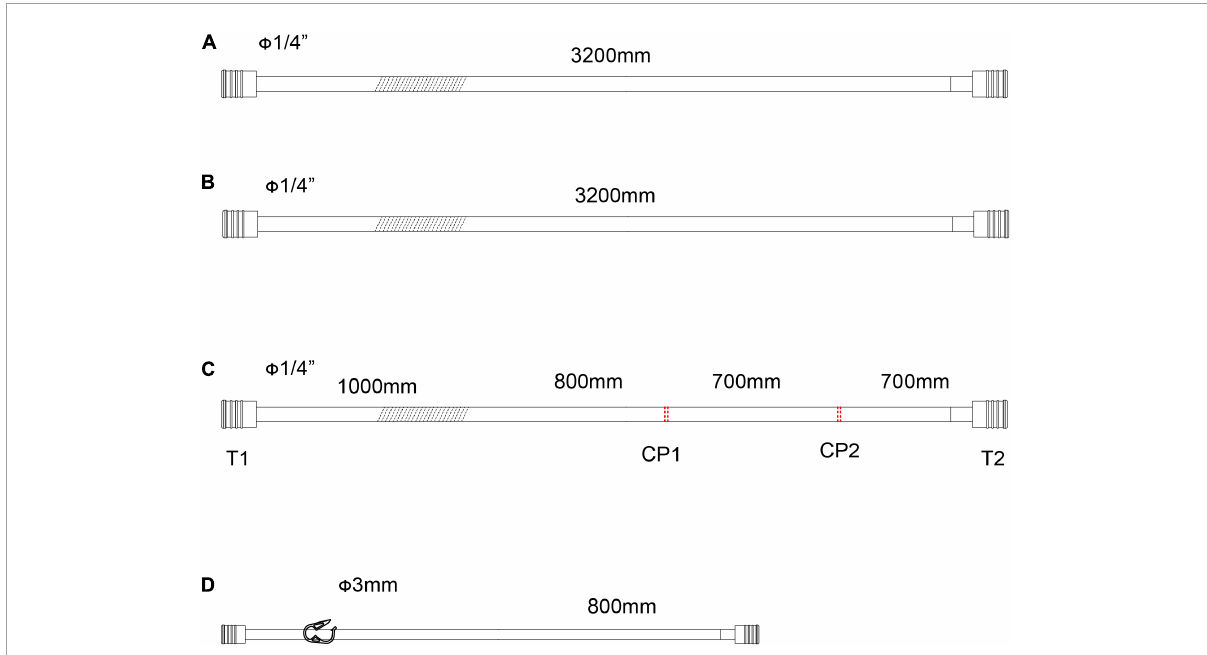
FIGURE3 The accessory pipelines for shed blood collection, rapid infusion and blood sampling. (A,B) Pipeline for the sucker. The line marked oblique dotted line is used for roller pumps. (C) Accessory pipelines for rapid infusion, S1 is the cut-point for connection of ultrafilter, and S2 is the cut-point for an arterial filter. The line marked oblique dotted line is used for roller pumps. (D) The accessory pipelines for blood